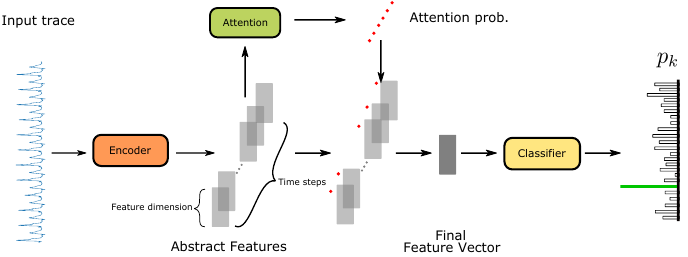
Figure 2: Abstract architecture from the side-channel point of